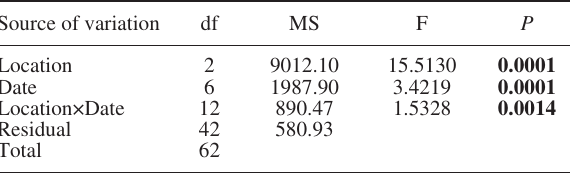
Table 2. – Results of PERMANOVA analysis of community struc- ture (cover database) for the factors Location and Date (fixed fac- tors). Bold : significant P values; * P < 0.05.